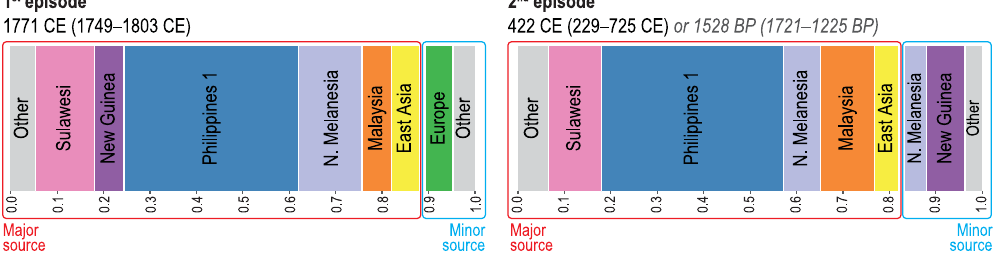
Figure 3. Population admixture events and inferred contact dates. Admixture events between genetic clusters obtained using fineSTRUCTURE 37 (FS, Supplementary Fig. S6) and estimated with GLOBETROTTER 38 (GT, Supplementary Table S8) for the Leeward Society Isles group. Each color represents a separate genetic cluster estimated with FS that acts as a donor to the recipient cluster (Leeward Society Isles) in the GT analysis. These donor groups are: Europe, East Asia, Malaysia, northern Melanesia (Bougainville), Philippines (‘Philippine 1’ cluster in FS), New Guinea and Sulawesi. ‘Other’ represents an amalgamation of groups contributing less than 3% ancestry to the admixture episodes in the genomes of Leeward Society Islanders. There is strong statistical support for two episodes of admixture; the ancient and recent events are represented by the left- and right- hand bar plots, respectively. Each episode involves two pairs of sources (minor and major); bar plots depict the inferred composition of the mixing sources for each, with admixture dates calculated using a generation time of 28 years. The dates for the older episode are given in the format of Common Era (CE) and Before Present (BP) for convenience. Detailed information about the inferred admixture episodes and composition of mixing sources is given in Supplementary Table